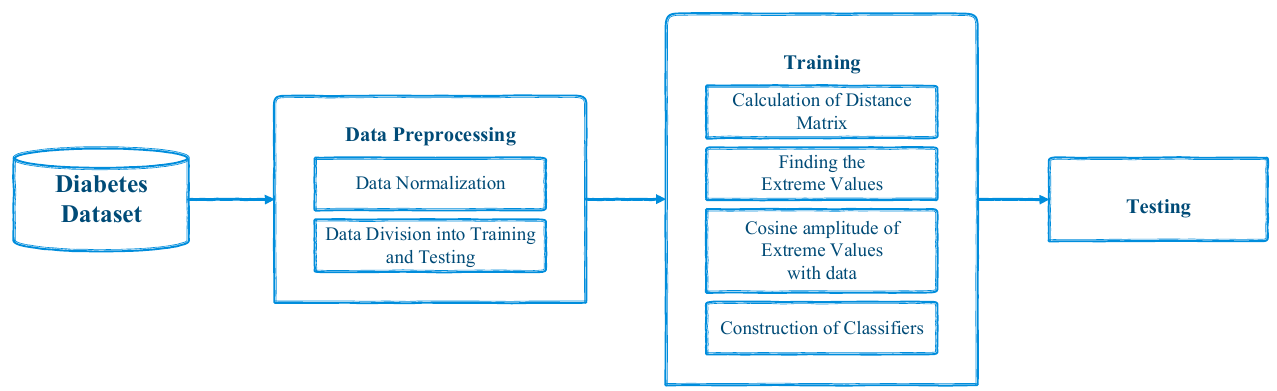
Figure 1. The framework of the proposed system.